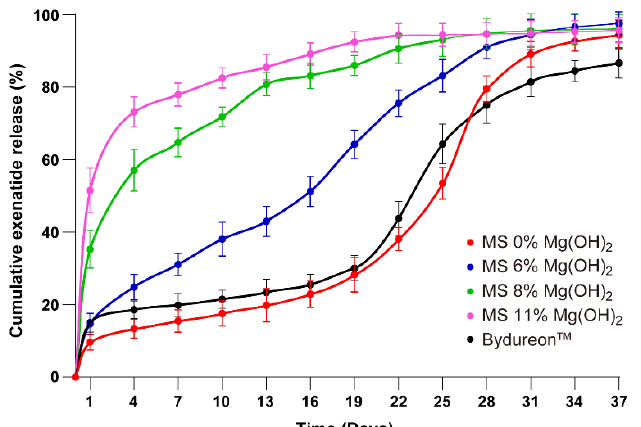
Figure 3. Cumulative exenatide release profile of microsphere formulations (means ± SD, n = 3). 1: MS 0% Mg(OH) 2 , 2: MS 6% Mg(OH) 2 , 3: MS 8% Mg(OH) 2 , 4: MS 11% Mg(OH) 2 , 5: Bydureon TM (1/5 vs. 2–4, p < 0.05; 2 vs. 3/4, p < 0.05).